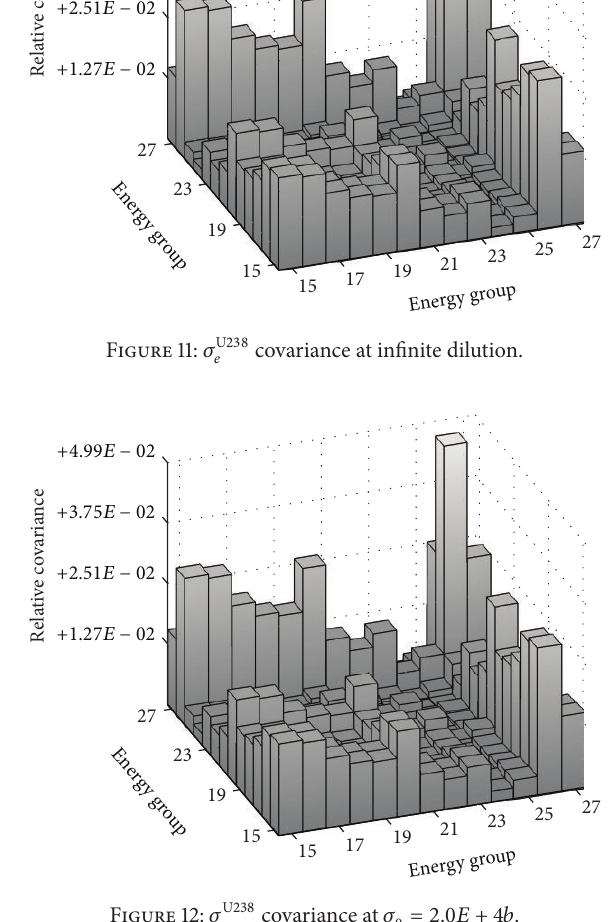
Figure 12: 𝜎 U 238 𝑒 covariance at 𝜎 0 = 2.0𝐸 + 4𝑏 .